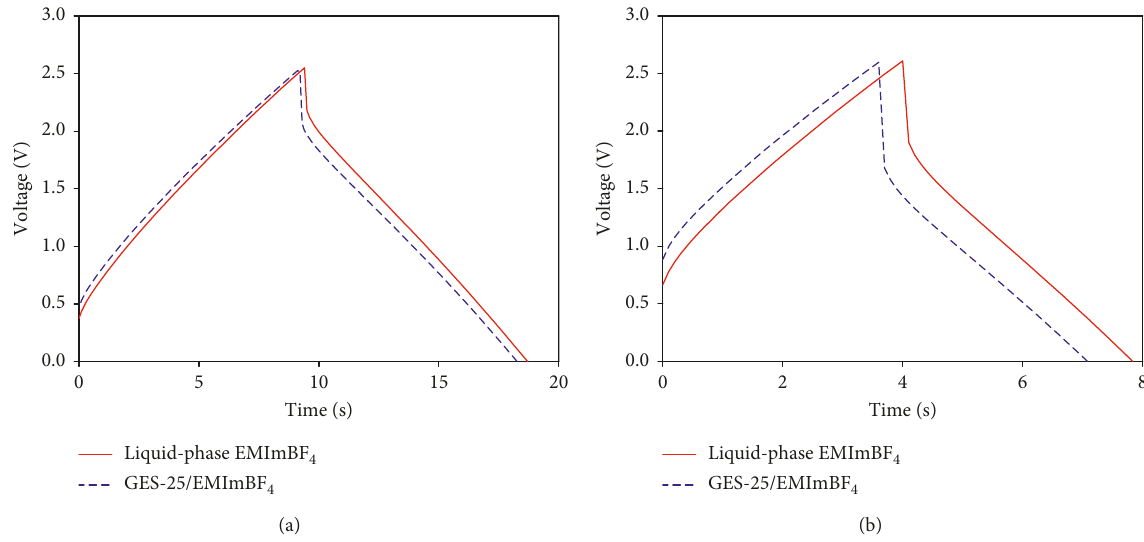
4 and with GES-25/EMImBF 4 as the electrolytes at